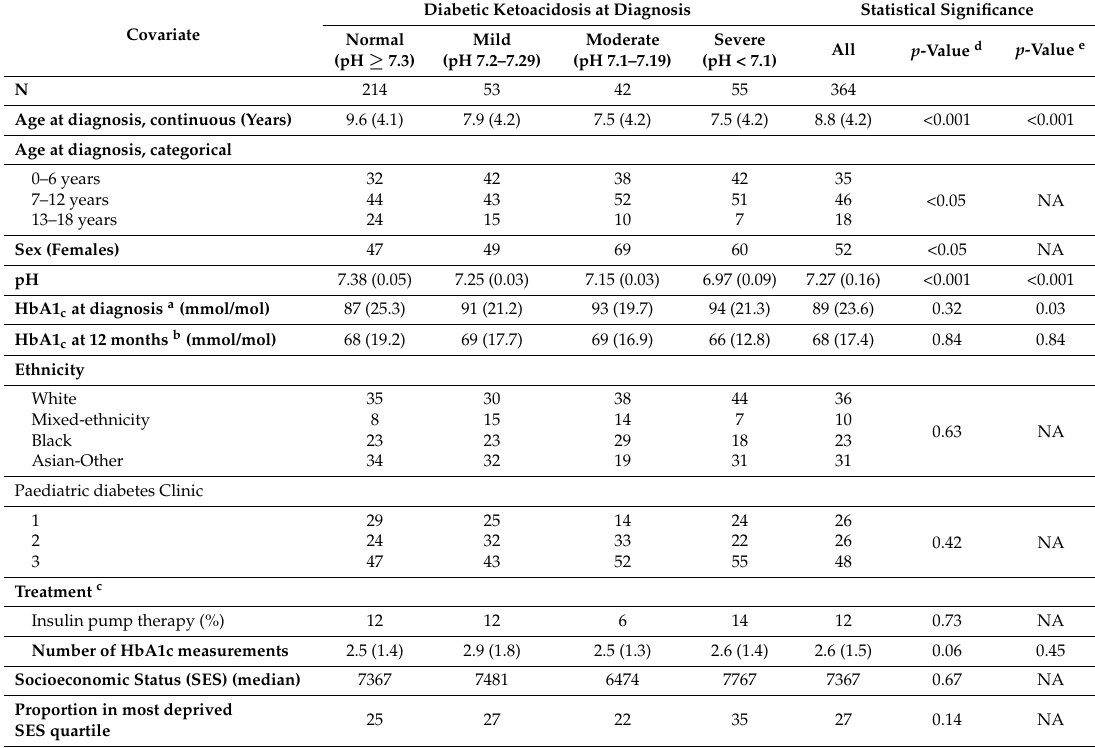
Table 1. Characteristics of 364 children and young people diagnosed with type 1 diabetes between 2005 and 2015 and attending paediatric diabetes clinics in East London. Values are means (SD) or proportions.